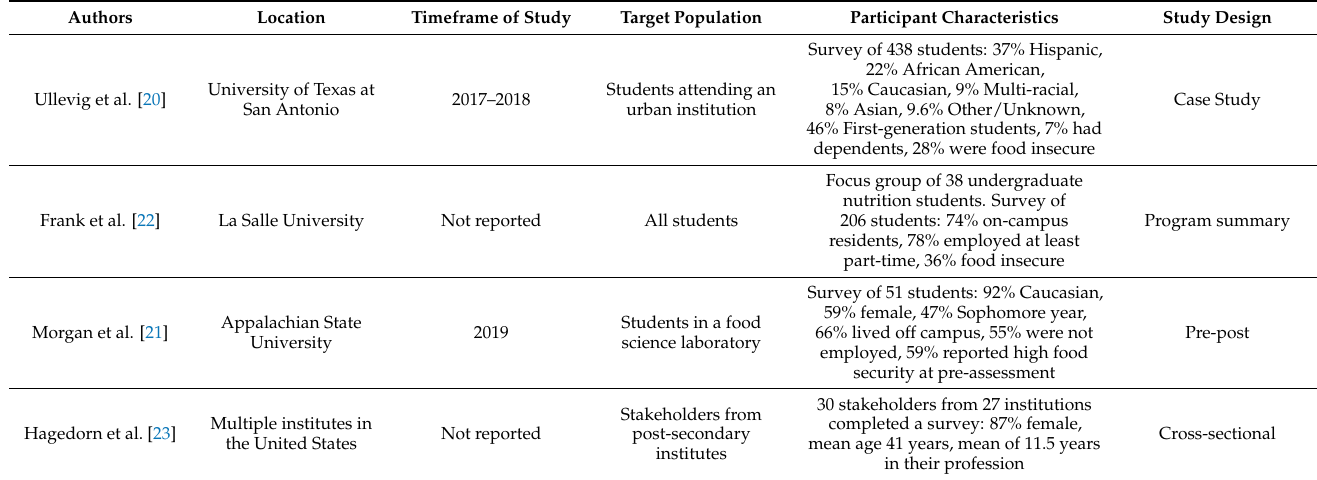
Figure 1. Overview of the study identification and screening process. Table 1. Characteristics of included